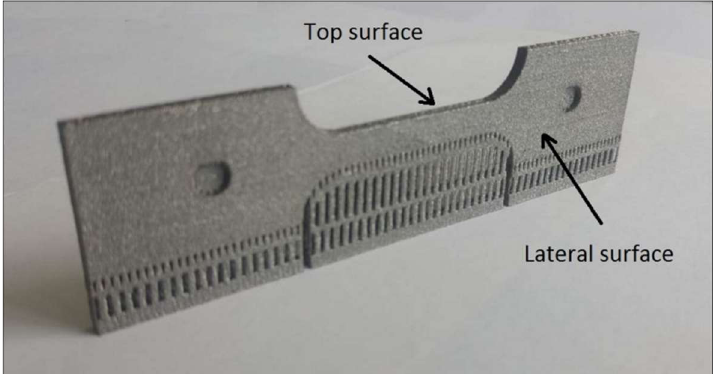
Figure 5. As printed specimen.